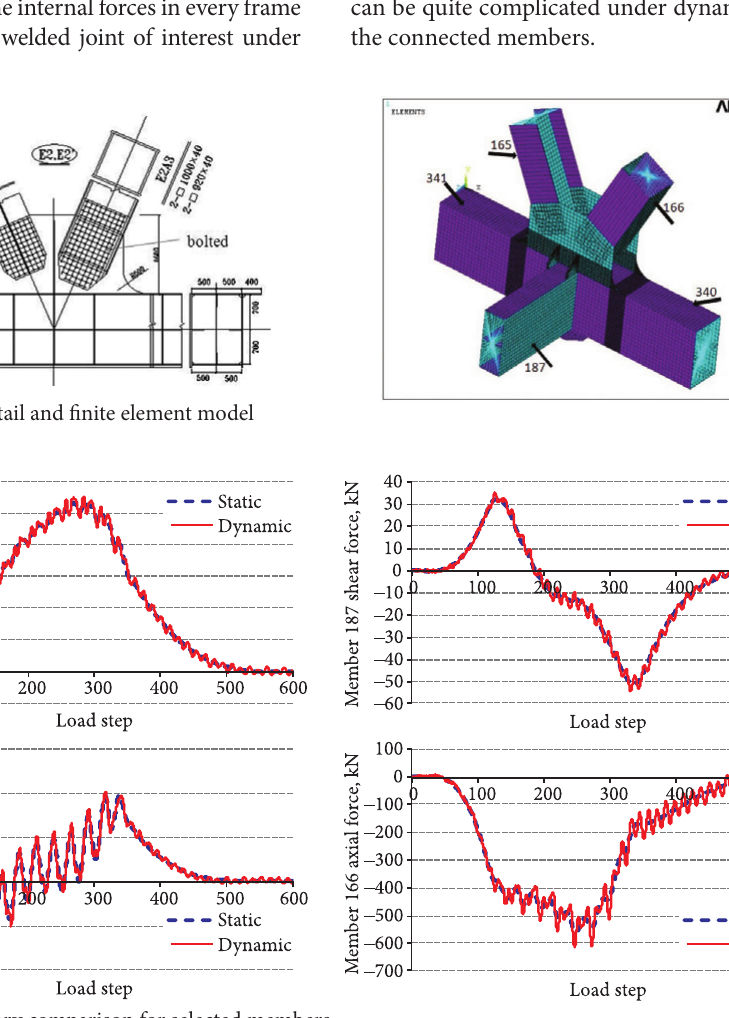
Fig. 6. Internal force time history comparison for selected